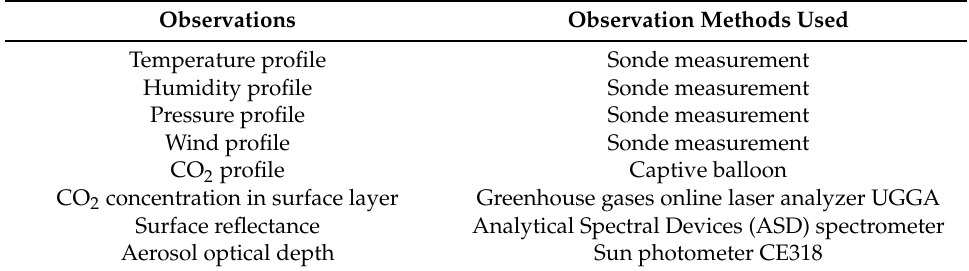
Table 3. List of ground observations and methods used to gather them.